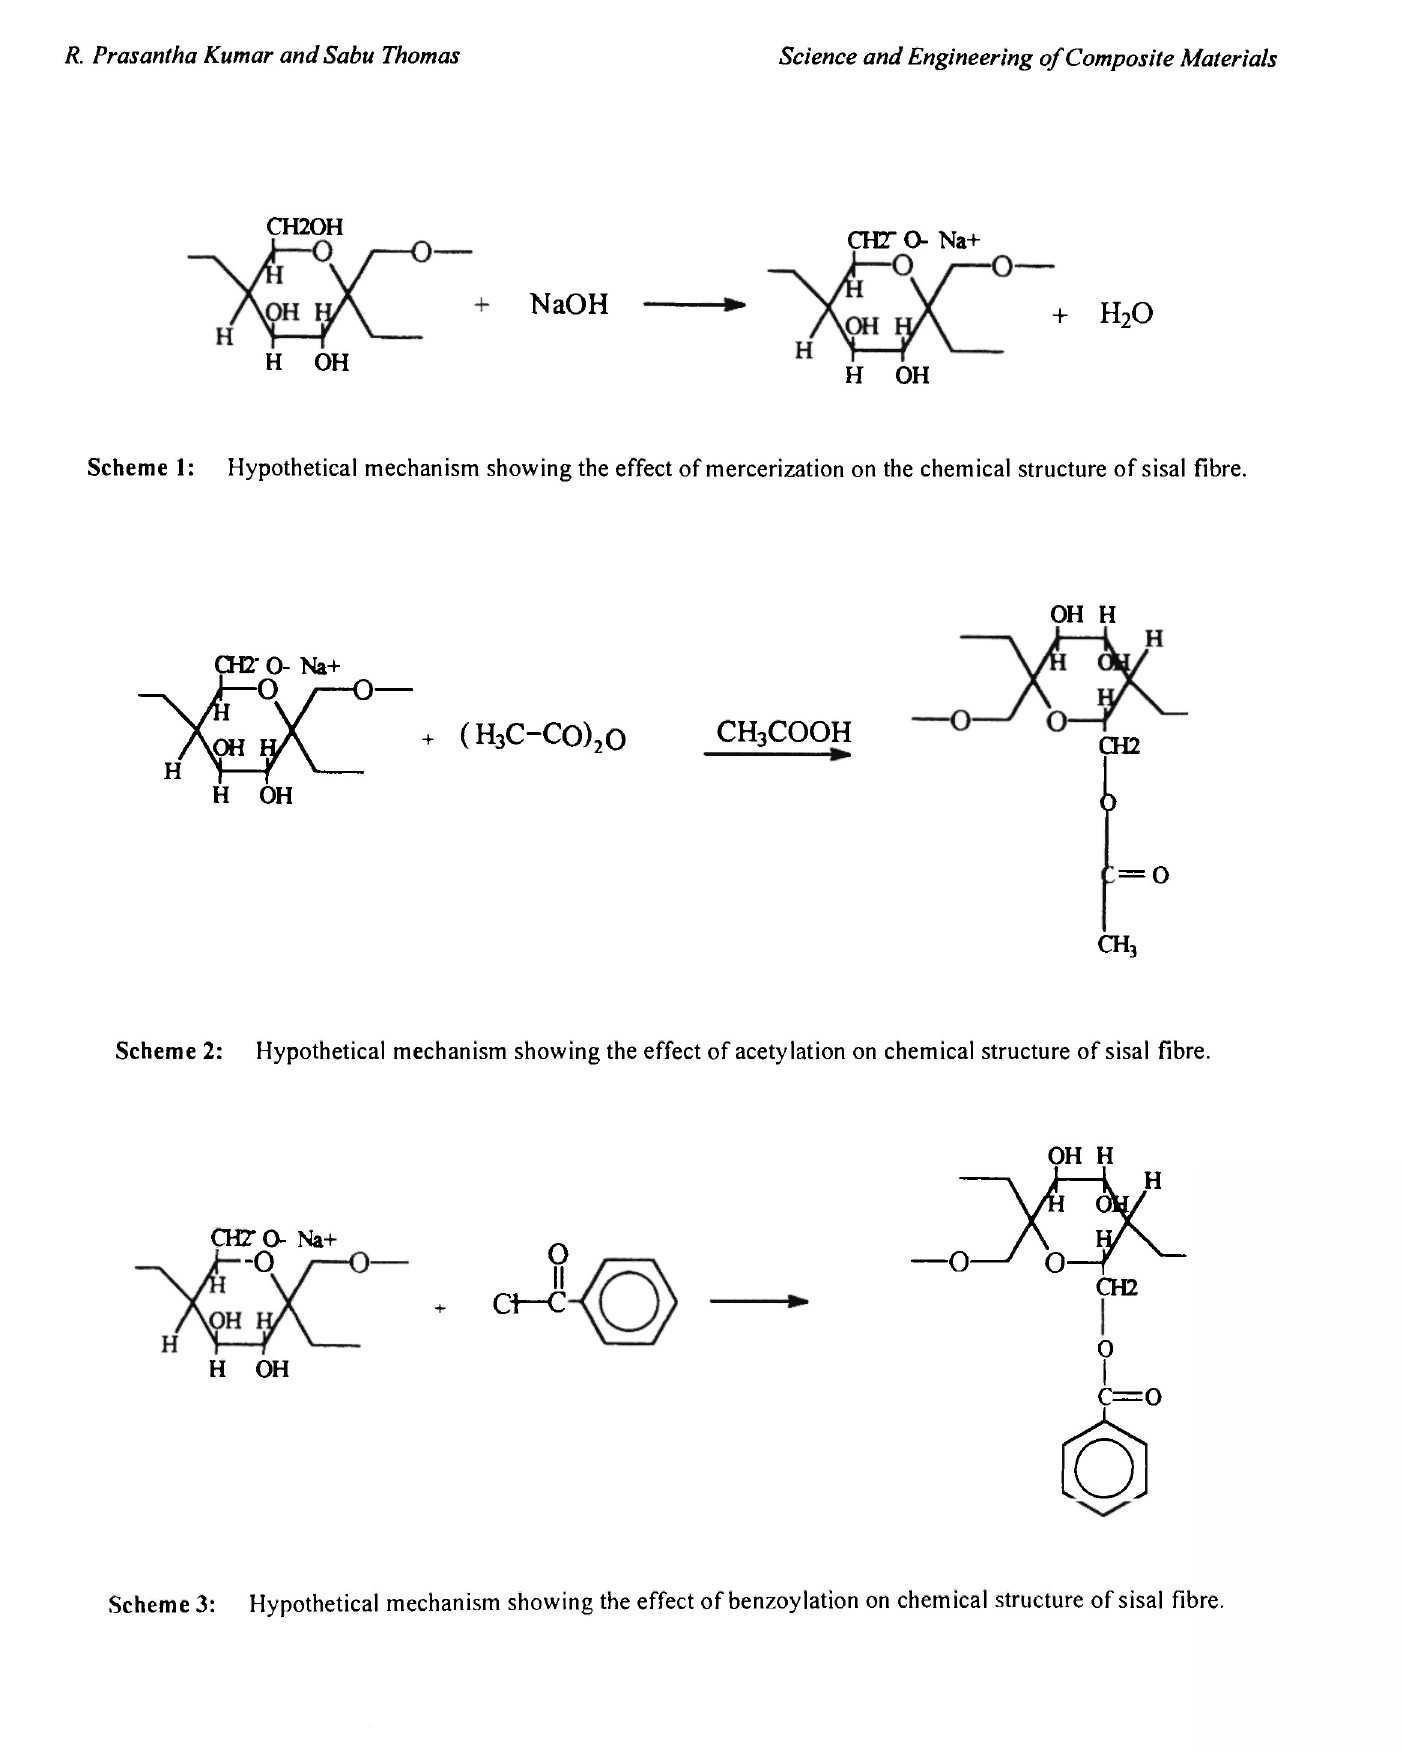
Hypothetical mechanism showing the effect of benzoylation on chemical structure of sisal